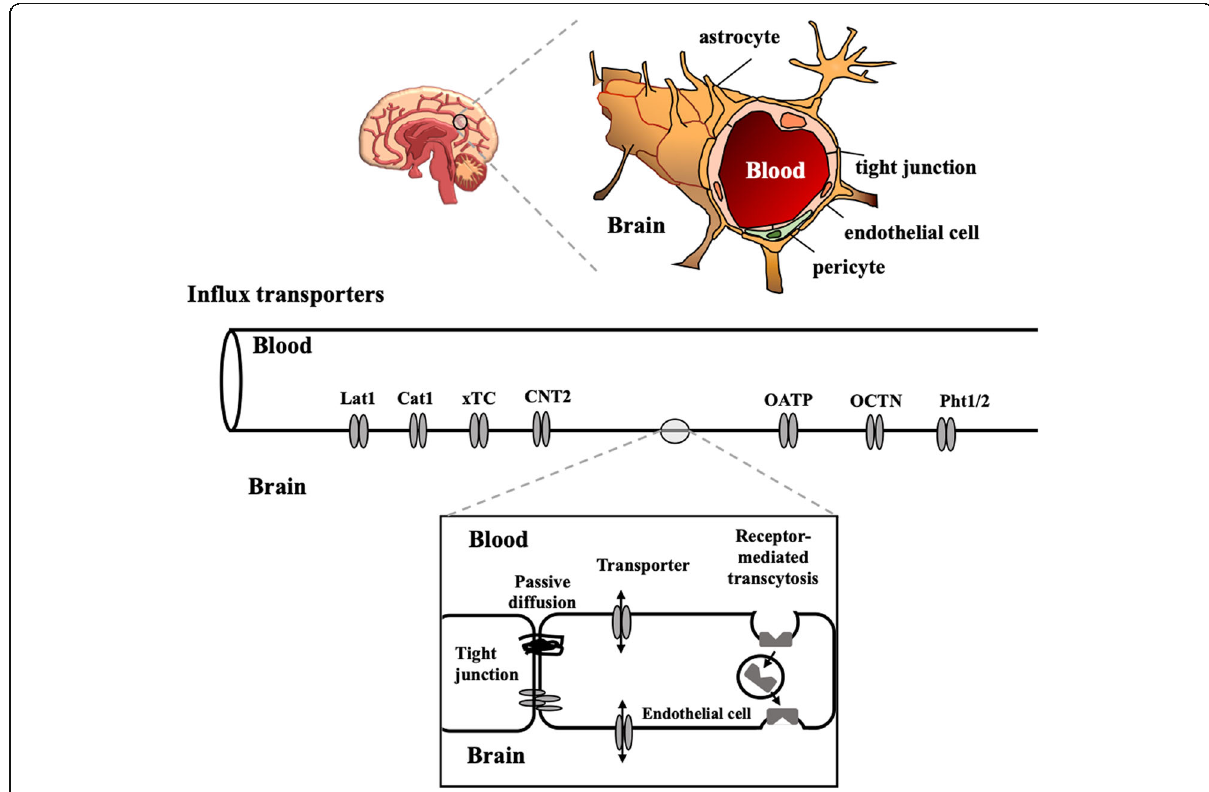
Fig. 1 Blood-brain barrier and transporters for influx routes. Lat1, large neutral amino acid transporter 1; Cat1, high affinity cationic amino acid transporter 1; xTC, cystine/glutamate transporter; CNT2, concentrative nucleoside transporter; OCTN, organic cation/carnitine transporter; OATP, organic anion transporting polypeptide; Pht1/2, peptide/histidine transporter